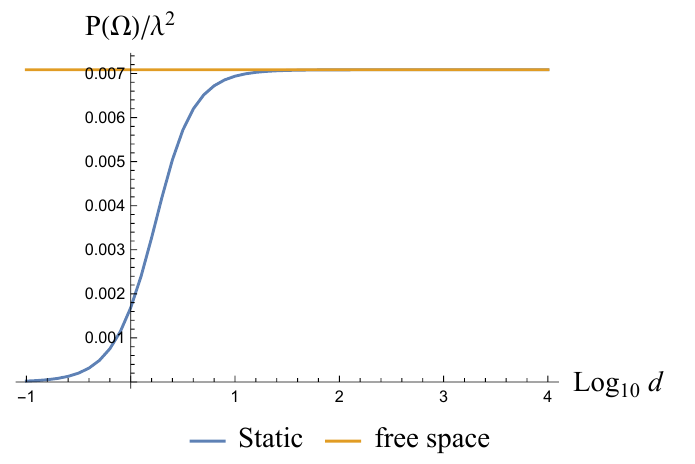
Figure 7 . Transition probability for Gaussian switching (cid:27) = 1 and (cid:10) = 1 ((cid:10) (cid:27) = 1) in (3 + 1) D . Near the mirror P ((cid:10)) decays quickly, and far from the mirror the contribution from the image term vanishes quickly. In this (cid:12)gure the asymptotic behaviour is reached at d=(cid:27) (cid:24) 10 2 . the (cid:12)nite width Gaussian window suppresses contributions at large u . Hence, in (3+1) dimensions the phenomenology of inertial (static) detectors in Minkowski half-space has the expected free-space limit as d ! 1